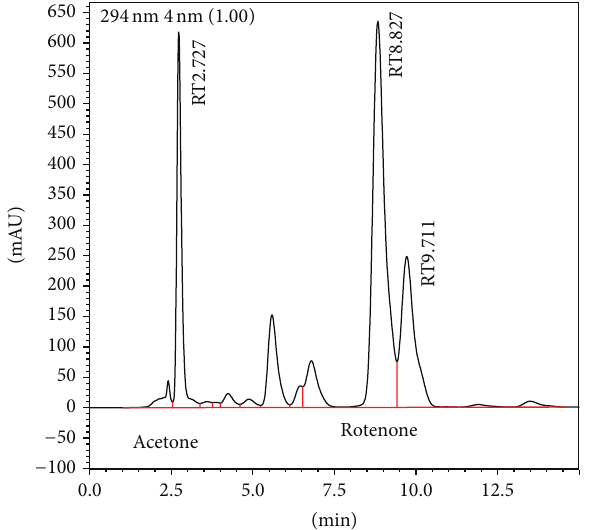
Figure 7: Chromatogram of [BMIM] OTF + acetone binary solvent system at 14